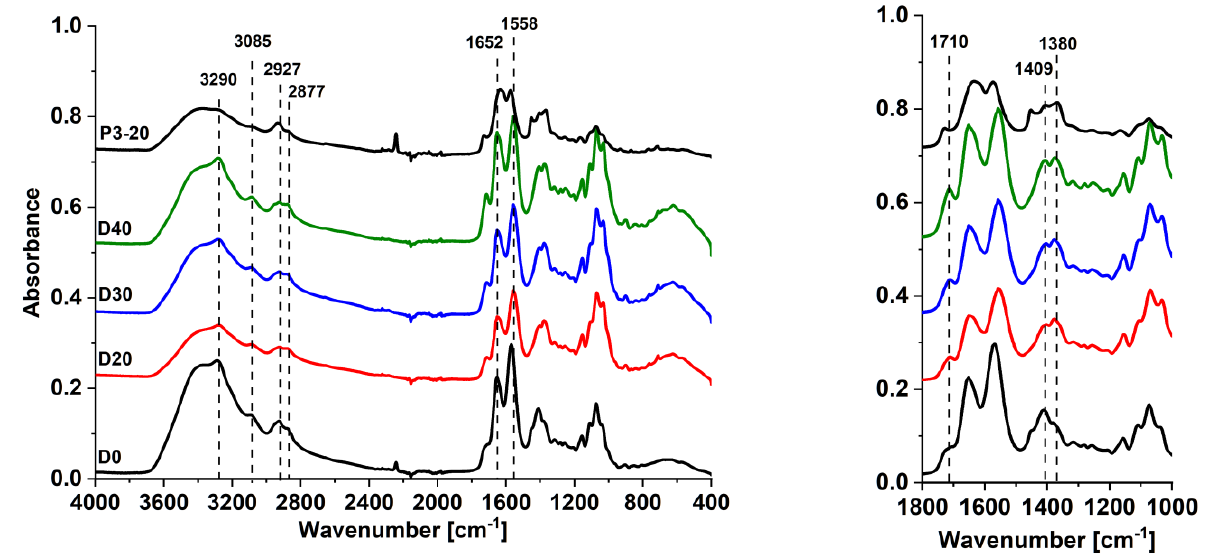
Figure 2. FTIR spectra of the surface of the selective layers of ChS/PAN (D0), TFN ChS-Fe-BTC/PAN membranes prepared by dynamic technique (D20, D30, D40) and physical adsorption (P3-20) technique.